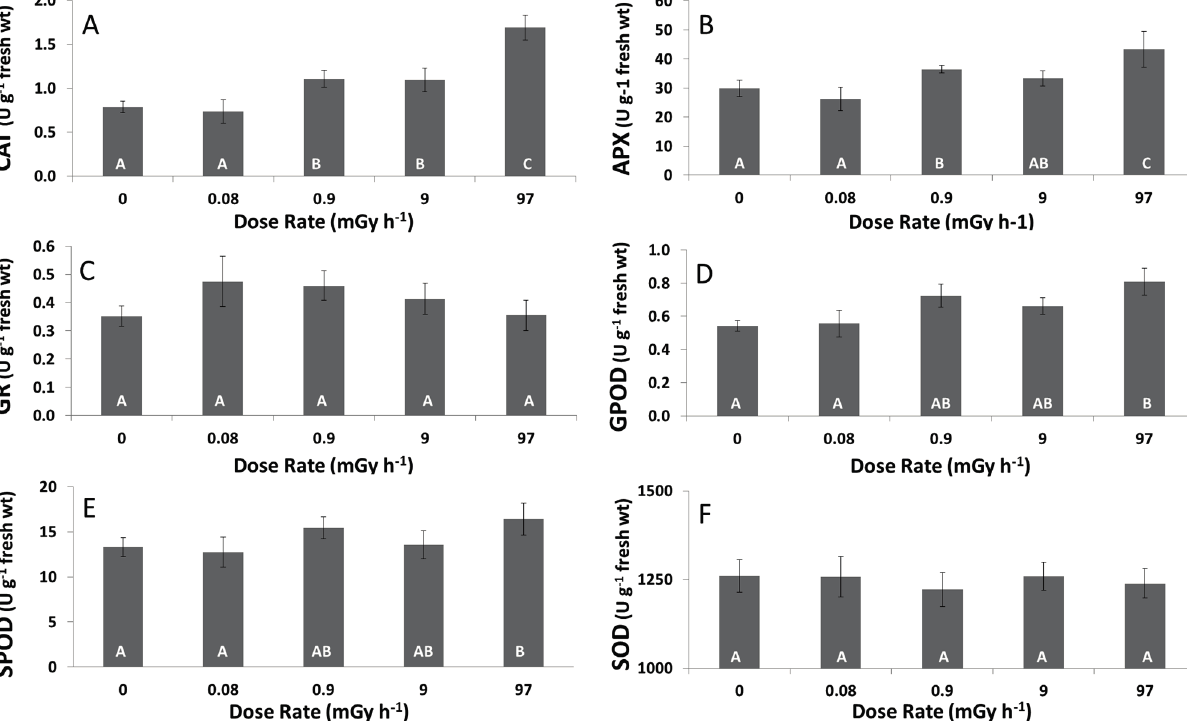
Figure 3. Enzyme activities of ( A ) catalase (CAT); ( B ) ascorbate peroxidase (APX); ( C ) glutathione reductase (GR); ( D ) guaiacol type peroxidase (GPOD); ( E ) syringaldizine peroxidase (SPOD); and ( F ) superoxide dismutase (SOD) in L. minor exposed to different dose rates levels of β -radation for seven days. Each data point represents the mean ± SE